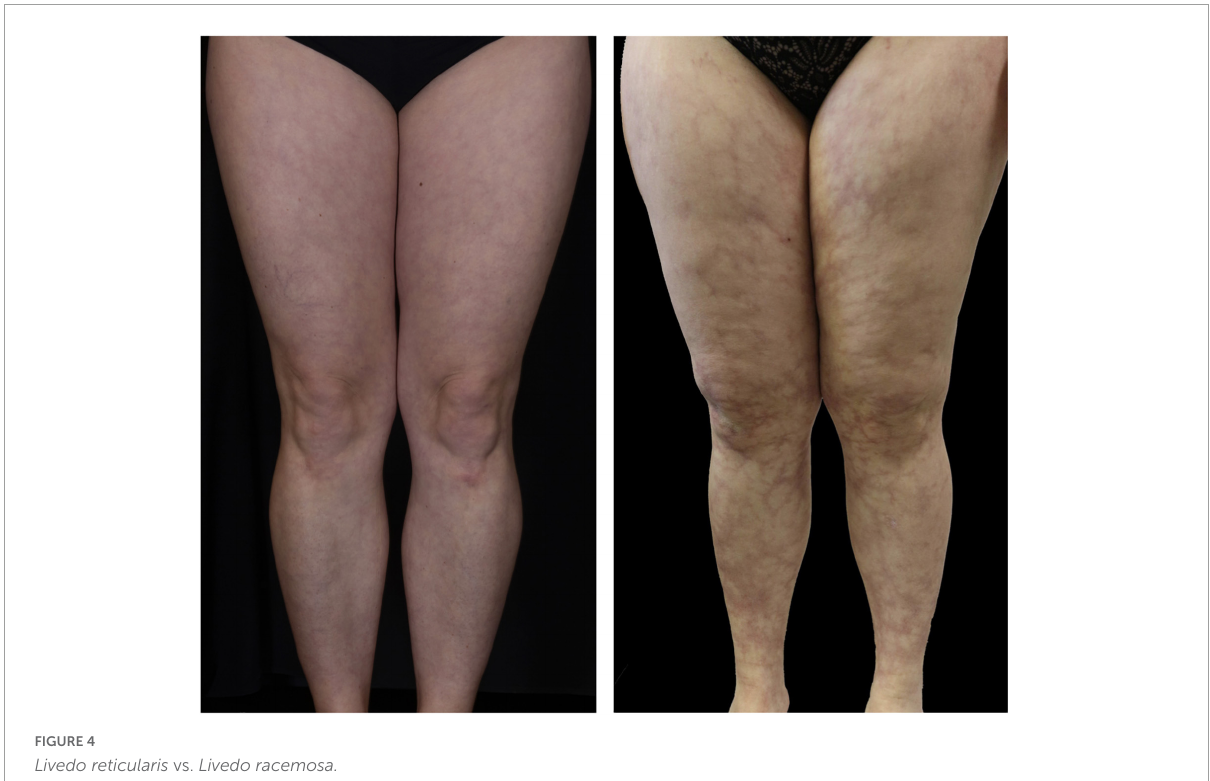
FIGURE4 Livedo reticularis vs. Livedo racemosa.